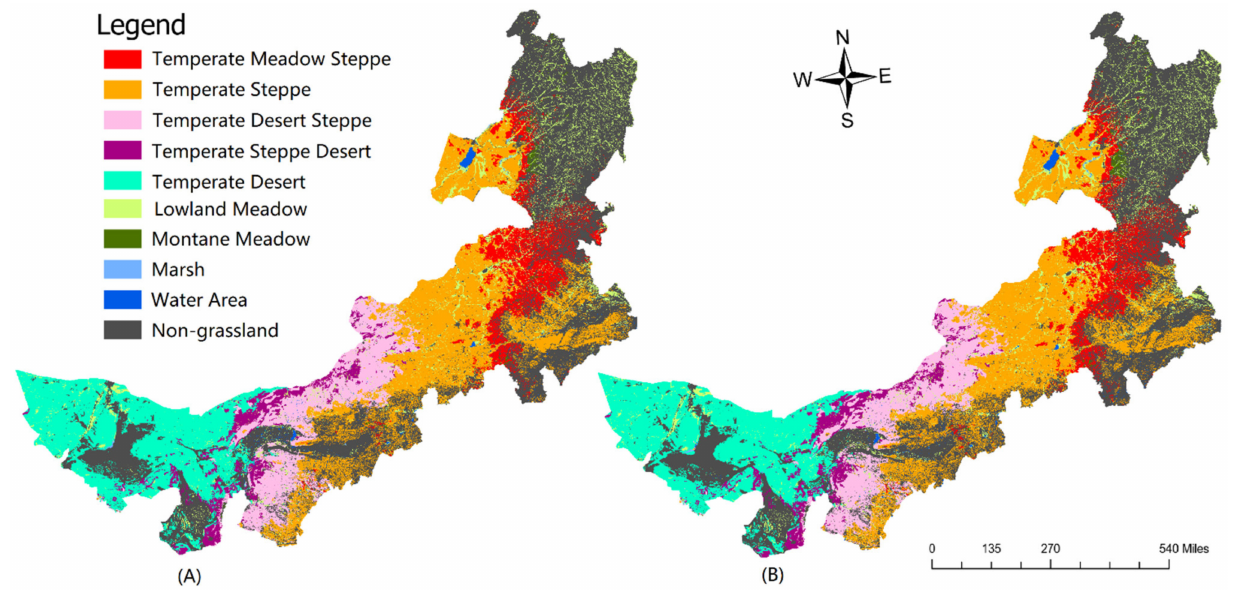
Figure 3. Overall results. ( A ) Actual LULC mapping for 2016 and ( B ) LULC mapping with simulated gap filling for